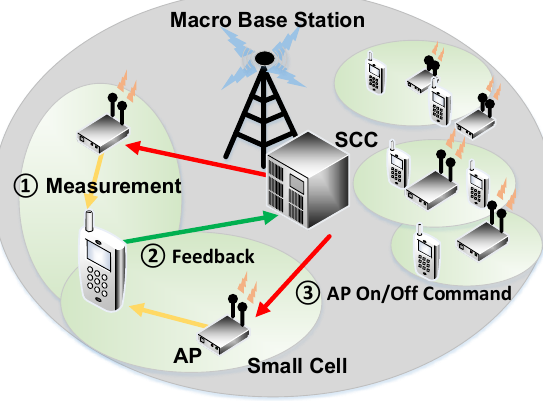
Figure 1. System model of the green small cell operation assisted by